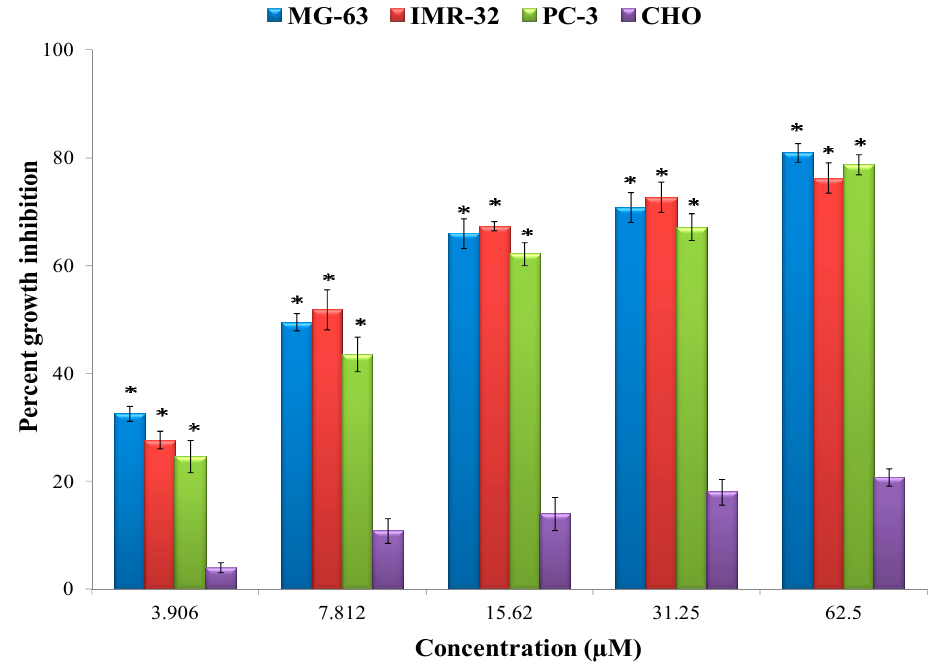
Figure 9. Antiproliferative activity of Epiafzelechin isolated from C. fistula on different cell lines in the MTT assay ( n = 60). * indicates statistically significant difference at ( p ≤ 0.05).